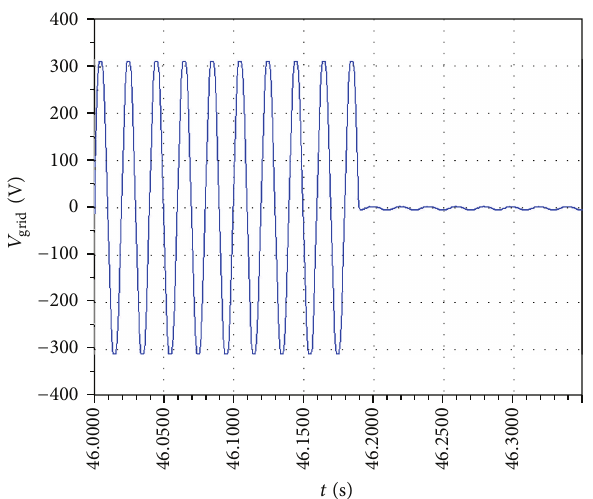
Figure 26: Grid voltage for over voltage condition.